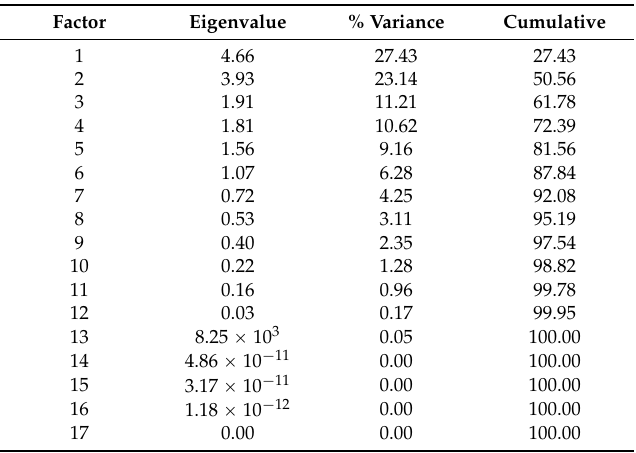
Table 5. Factor loadings and communalities for each variable under Varimax rotation.